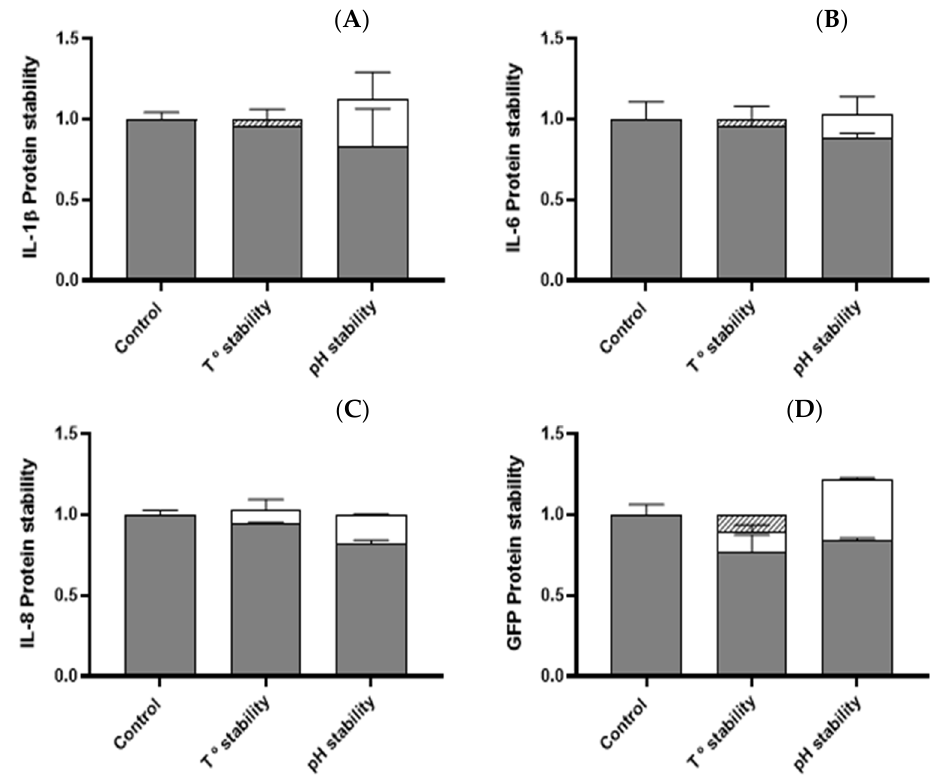
Figure 2. Protein distribution between soluble (white), insoluble (grey), or degraded fractions (striped) after temperature and pH challenge in ( A ) IL1 β -, ( B ) IL6-, ( C ) IL8-, and ( D ) GFP-based IBs. In samples of intestinal tissue, the immunostimulatory effect was assessed by the gene expression of the extracted RNA from tissue explants after 24 h (day 27) and 7 d (day 34) of the administration of IL-1 β nanoparticles (Table 5). No significant changes were observed in the ileum or jejunum for TNF- α , IL-6 , BD1 , BD2 , Muc1 , CLDN4 , or Occludin genes for both evaluated sampling times. Table 5. Cytokine gene expression analysis of ileum (A) and jejunum (B) after IL-1 β -based IB treat- ment and in the control treatment. The mean of each treatment and SEM are indicated. p -value < 0.05 indicates statistical differences. W: